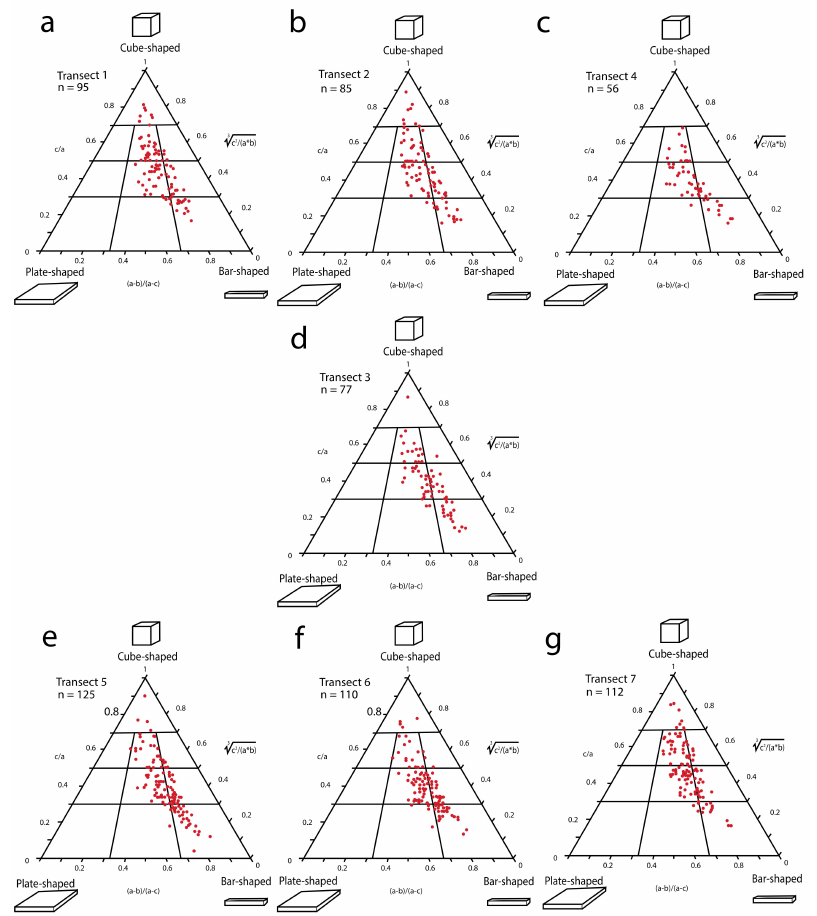
Figure 4. Set of triangular Sneed–Folk diagrams used to appraise variations in cobble and boulder shapes; ( a ) Trend from transect 1 closest to sea cli ff s at the source of the clasts; ( b ) Trend from transect 2; ( c ) Trend from transect 4; ( d ) Isolated trend from transect 3 with a markedly di ff erent orientation from all other transects; ( e ) Trend from transect 5; ( f ) Trend from transect 6; ( g ) Trend from transect 7 most distant from sea cli ff s at the common source of all clasts in the